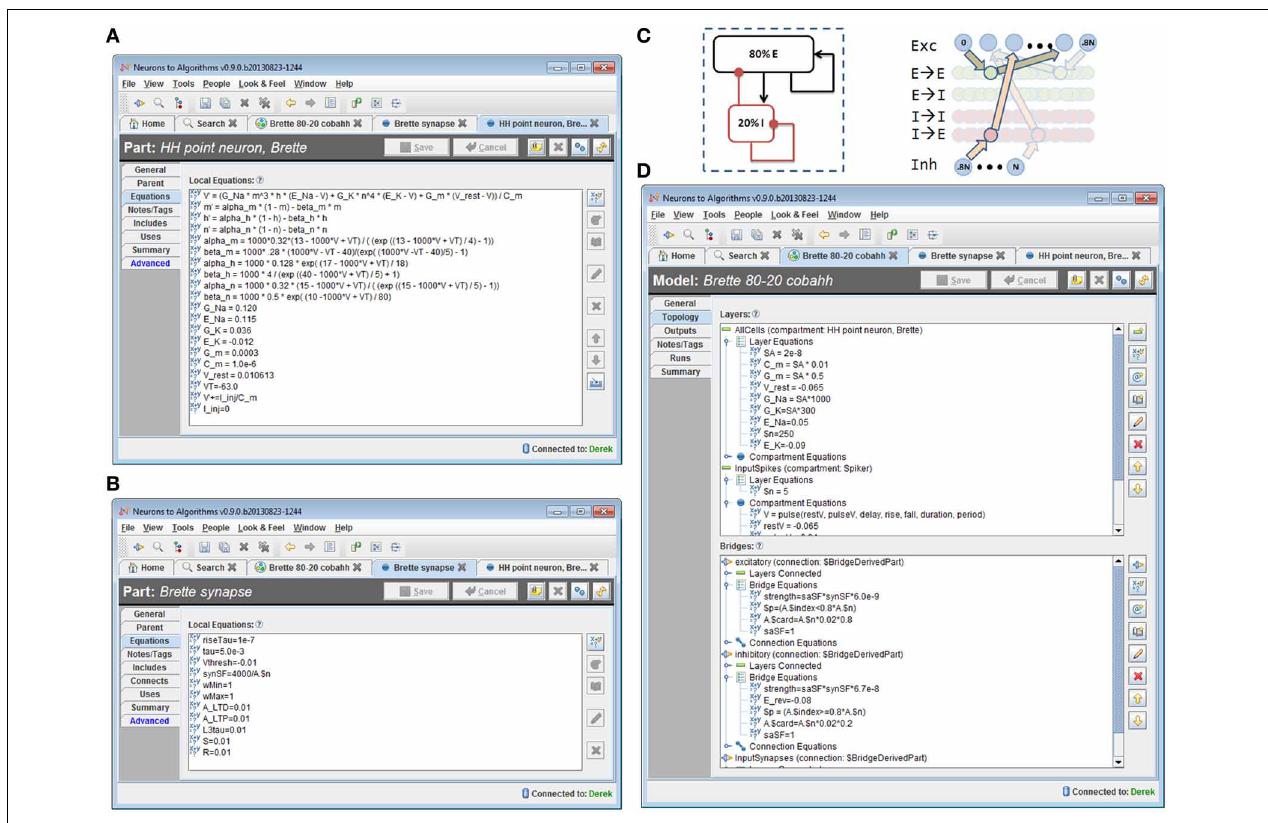
FIGURE 8 | 80/20 E-I network definition in N2A. (A) Screenshot of part equation set for spiking neurons used in 80/20 model. (B) Screenshot of synapse equation set for connections between neurons in 80/20 model. (C) Simple network illustration of 80/20 model from a block perspective (left) and